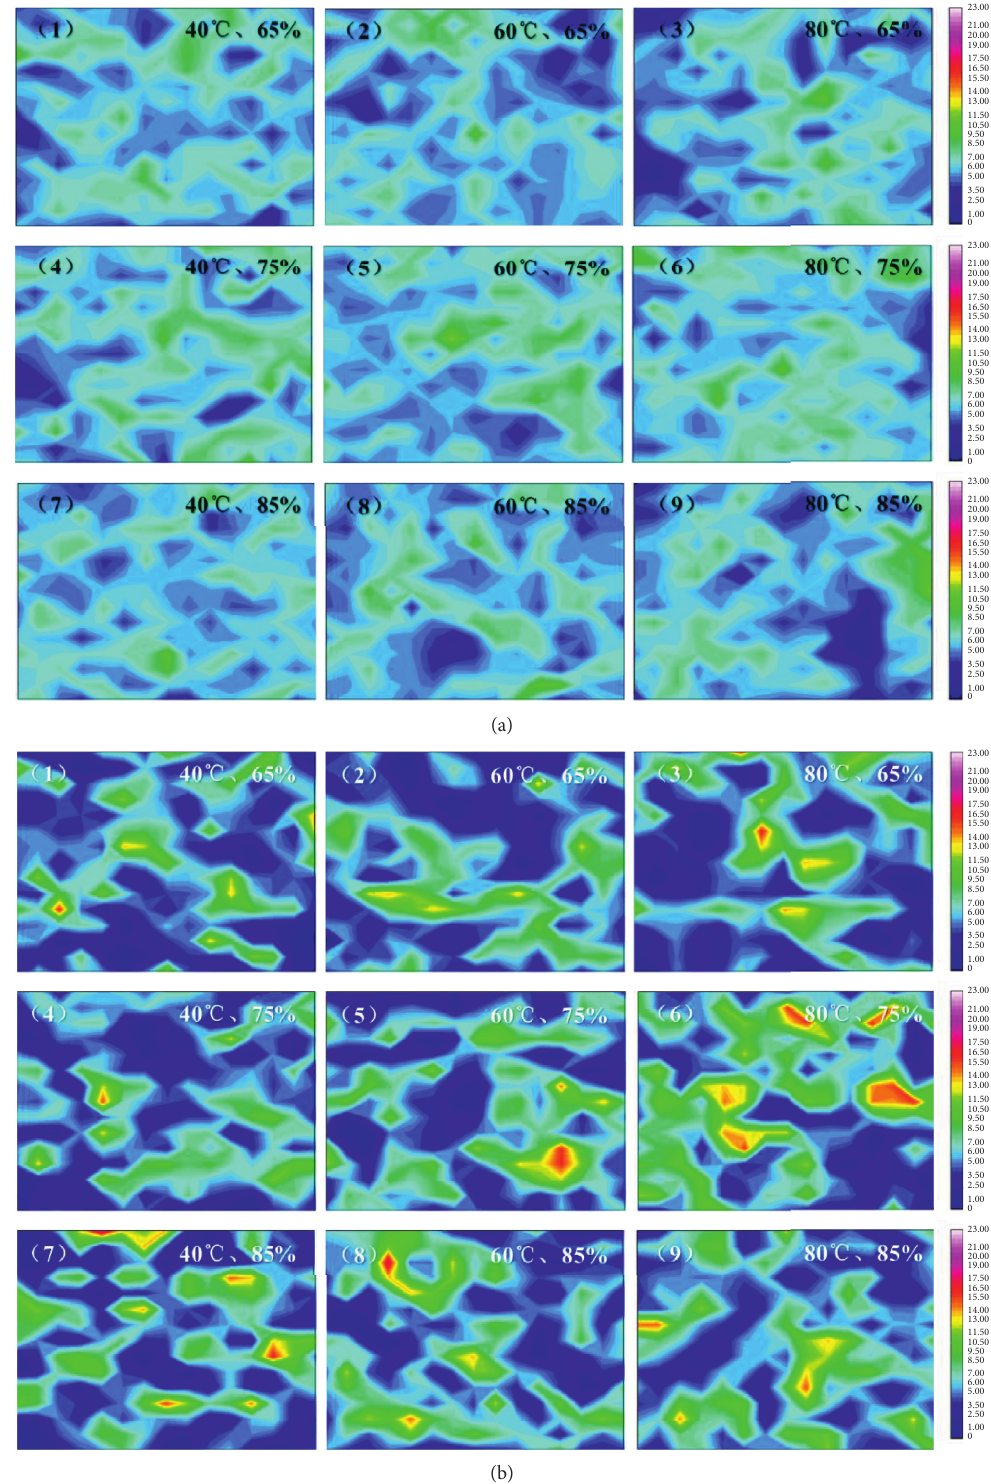
Figure 2: Contour plots of the variation of protein quantity for cross sections (a) and surfaces (b) of dried noodles at different drying temperatures and relative